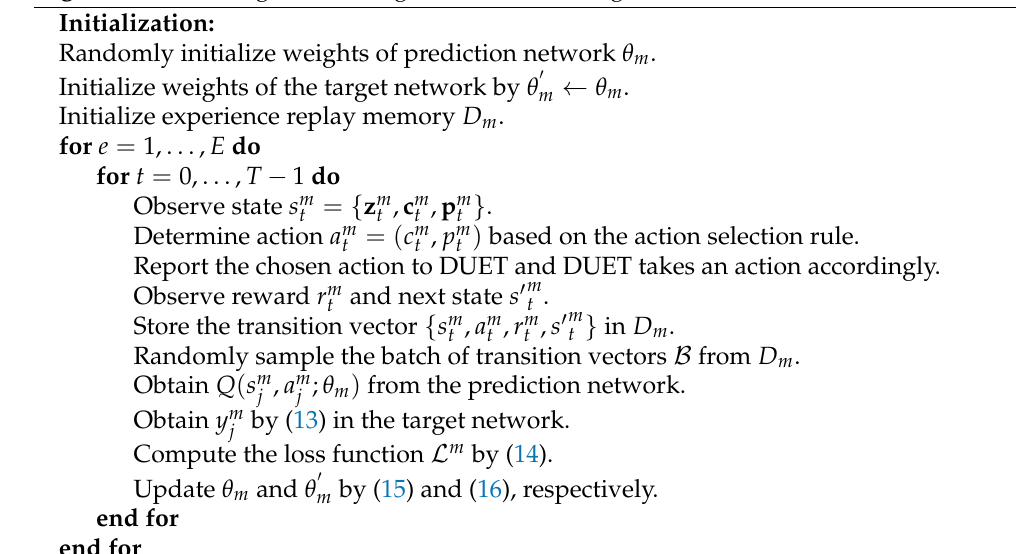
Algorithm 1 Training Phase of Agent m in a Multi-Agent DRL-Based RA